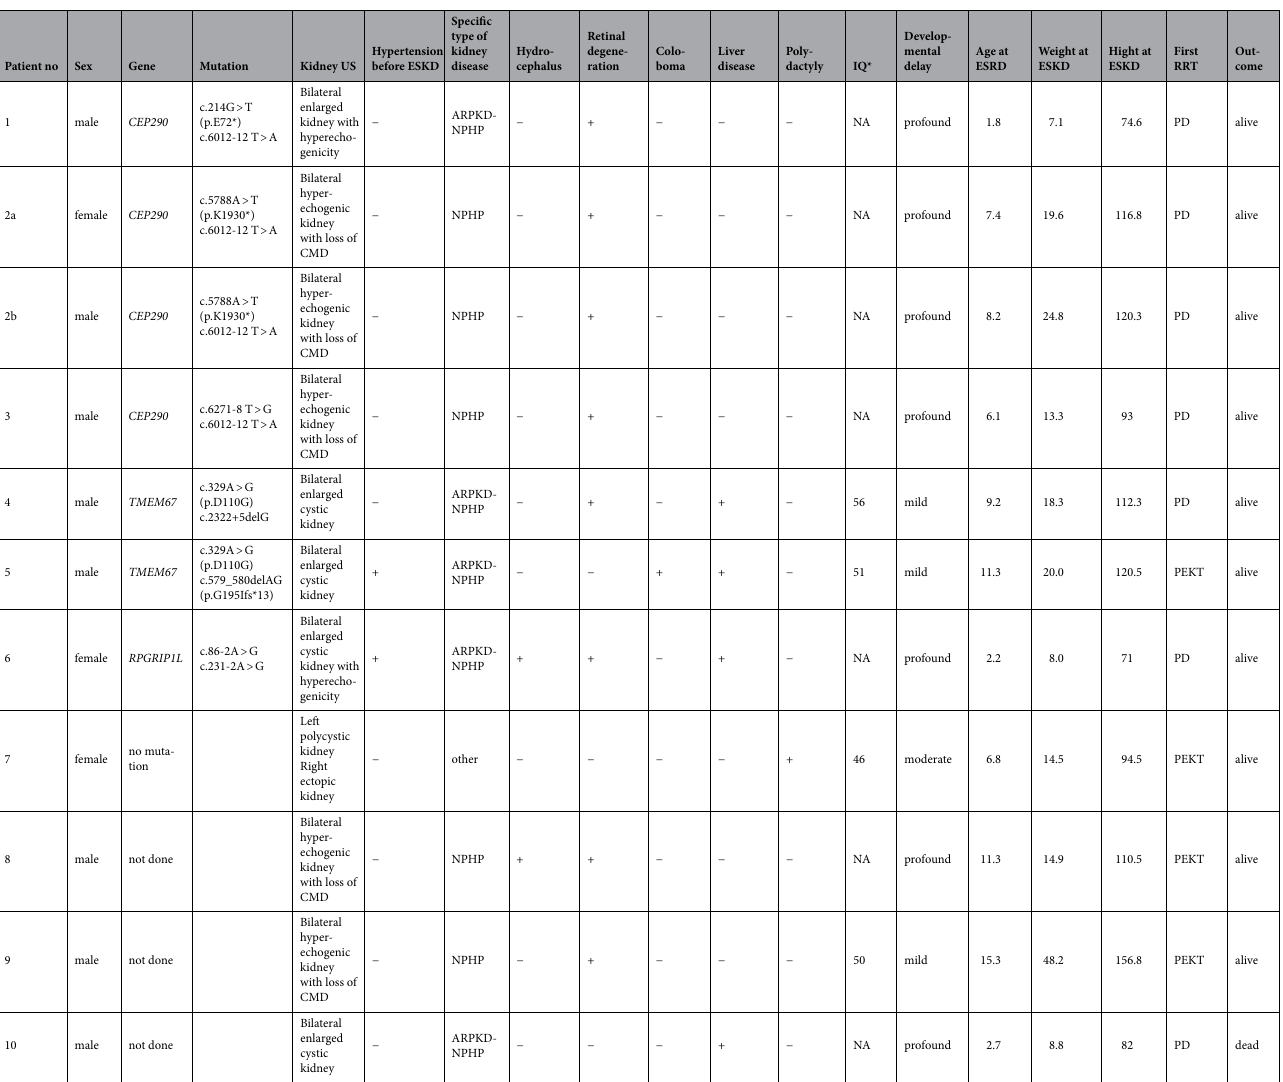
The specific type of kidney disease was classified as an overlap phenotype of autosomal recessive polycystic kidney disease and nephronophthisis (ARPKD-NPHP) in five patients and nephronophthisis (NPHP) in five patients. The remaining patient had a polycystic left kidney and an ectopic right kidney. Complications in other organs included hydrocephalus in two patients, retinal degeneration in eight, coloboma in one, liver disease in four, and polydactyly in one. The four patients with CEP290 gene mutations showed retinal degeneration, and the two patients with TMEM67 gene mutations had liver diseases. Developmental tests showed that seven patients had profound developmental delay, one had moderate delay, and three had mild delay. The four patients with CEP290 gene mutations had profound developmental delay, while the two patients with TMEM67 gene mutations had mild developmental delay. The median age at ESKD was 7.4 years (range 1.8–15.3) for all patients. The age at ESKD for the seven patients with profound developmental delay was 6.1 (1.8–11.3) years old, a younger age than the 10.3 (6.8–15.3) years for the patients with moderate/mild developmental delay, although there were no statistically significant differences between the two groups (Fig. 1a). In addition, the height and weight of the patients in the profound group tended to be lower compared with those of the patients in the moderate/mild group at the time of ESKD (Fig. 1b, c). The treatment decision made for the first RRT was as follows (Table 1): three patients (patient number 5, 7, 9) of the four patients with moderate/mild developmental delay underwent preemptive living donor kidney transplantation (LDKT), while one (number 4) underwent peritoneal dialysis (PD). Six (numbers 1, 2a, 2b, 3,